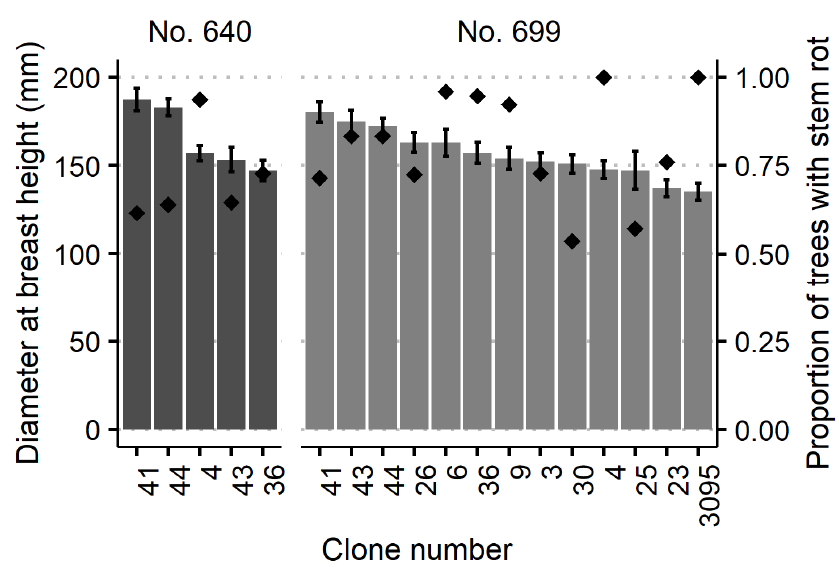
Figure 3. Clone mean diameter at breast height (bars; whiskers denote a 95% confidence interval) and the proportion of trees with stem rot (points) in the studied hybrid aspen trials 640 (age 13 years) and 699 (age 12 years).